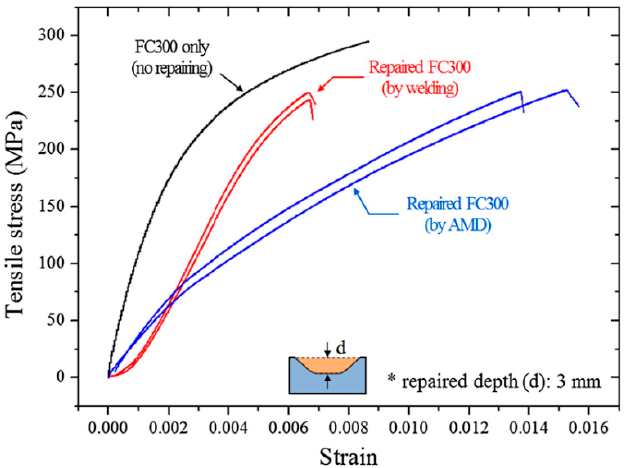
Figure 4. Tensile stress-strain curve of a cast-iron repaired via a traditional welding and DED process (AMD in the figure) [77].